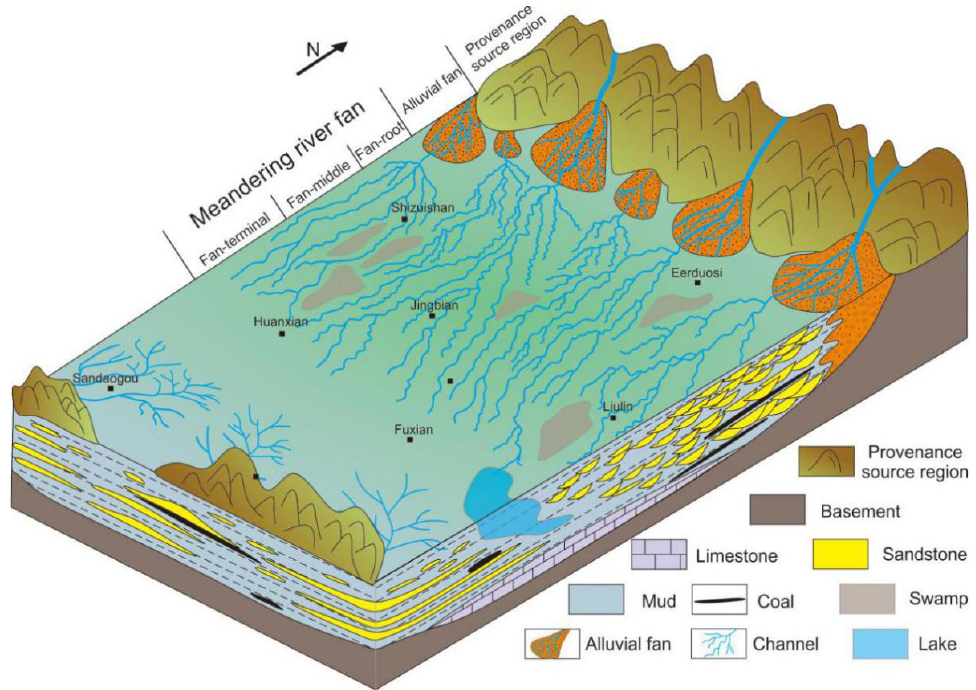
Figure 5. Depositional model of Shanxi Formation in the Ordos Basin.